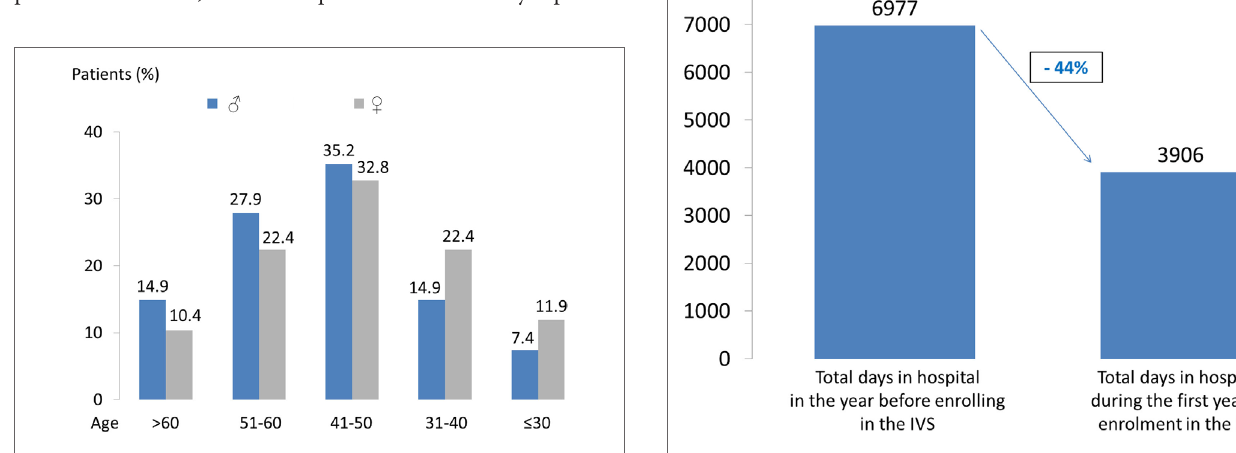
FigUre 2 | age and gender distribution of the 121 patients who completed the modified ZUF-8 questionnaire .